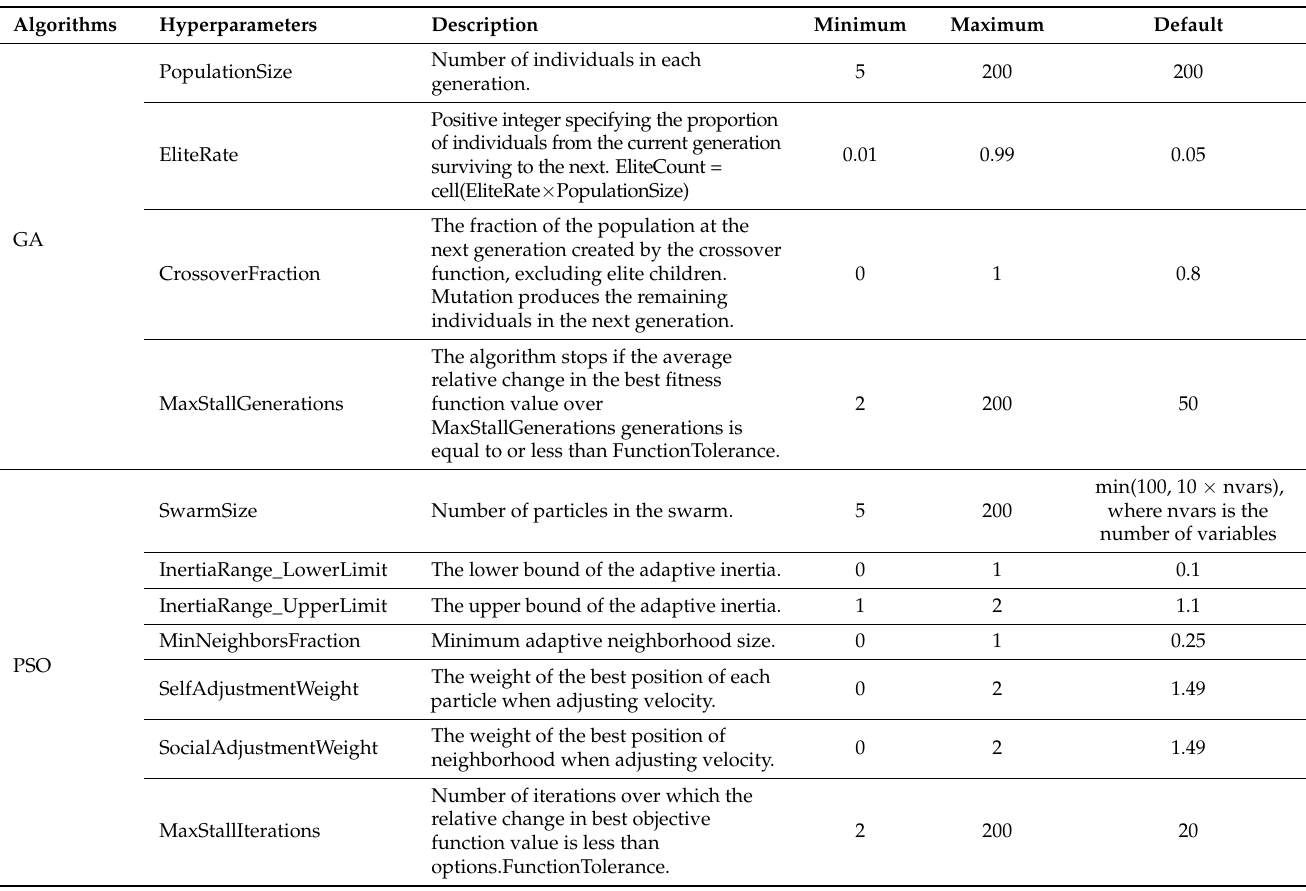
Table 4. Hyperparameters of the test optimization algorithms, their ranges, and default values in MATLAB.